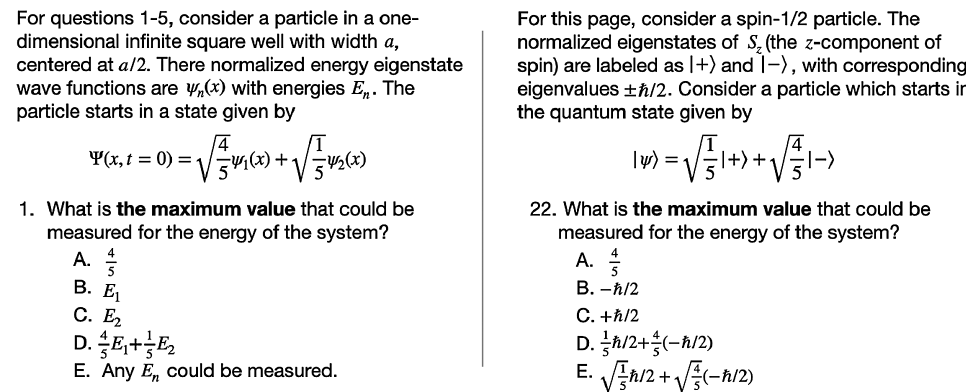
FIG. 2. Example of isomorphic questions. In the spatial wave function context students work with the energy eigenstates in the infinite square well. In the spins context, students work with spin- 1 = 2 and spin-1 systems. The states are both written with identical coefficients and the questions ask for the same conceptual information.